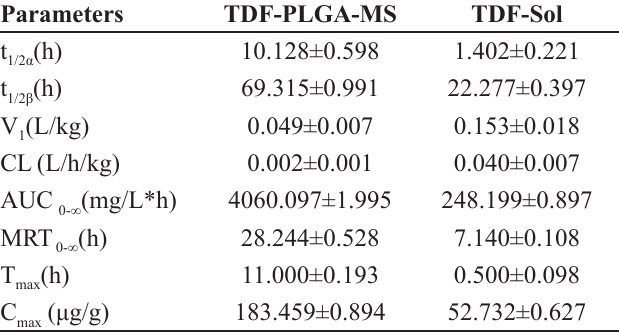
TABLE IV - The pharmacokinetic parameters in lung of TDF after intratracheal instillation of TDF -Sol and TDF-PLGA-MS Parameters